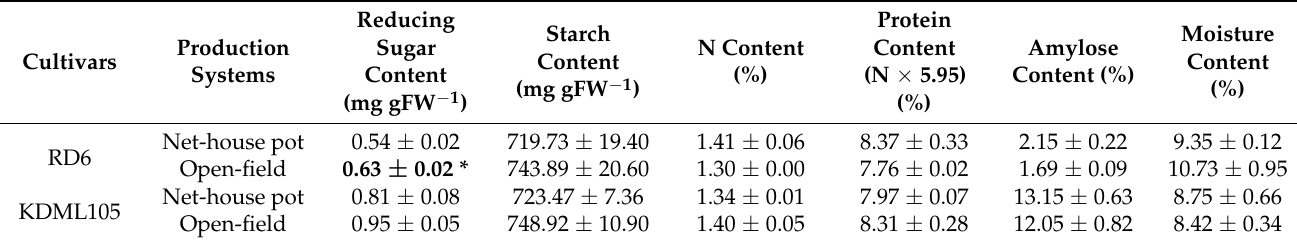
Values are means ± SEM. Means in bold within each column with the * symbol denote statistically significant difference between the two